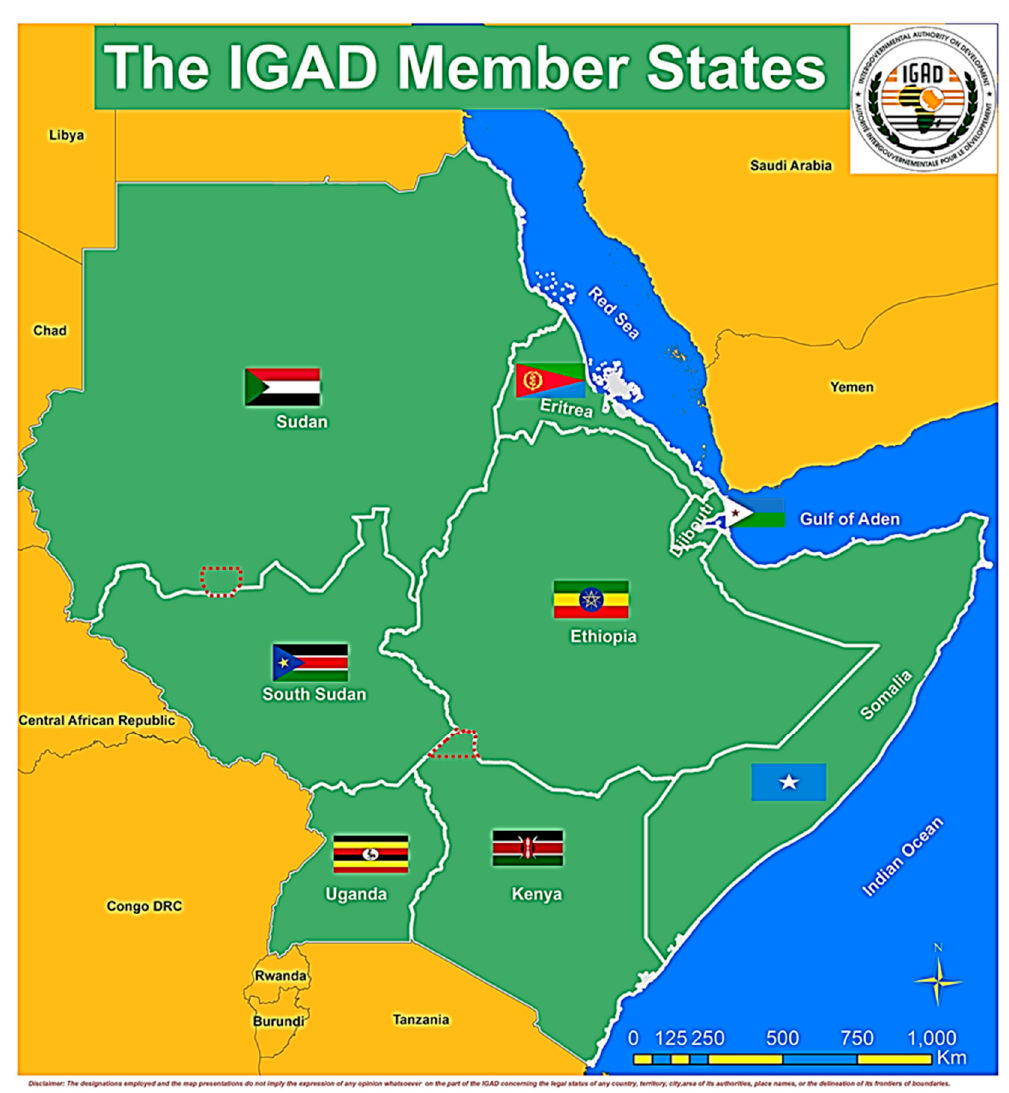
Figure 1. Map of countries making up the Horn of Africa [8].